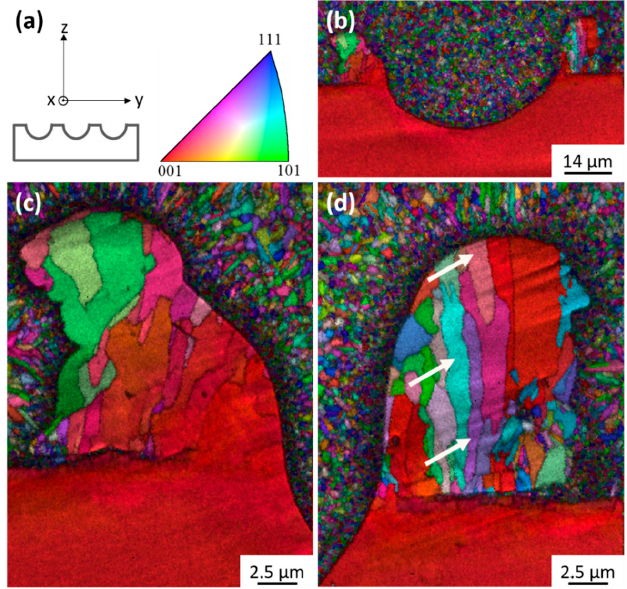
Figure 8. Crystallographic orientation mapping, coded along the z ‐ axis, of pattern 2: ( a ) reference frame and inverse pole figure ( b ) mapping of the entire pattern 2, ( c , d ) zoom on both asperities. The textured surface of the AM1 was previously nickel plated.